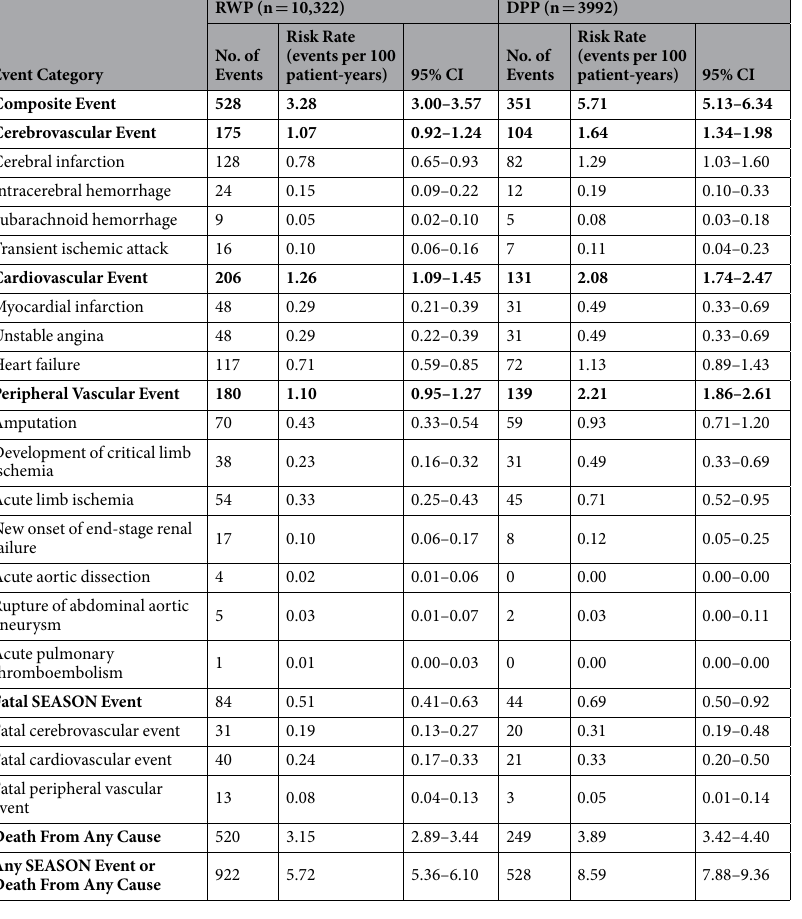
Table 2. Vascular Event and Mortality Rates Over 2 Years (RWP and DPP). Abbreviations: CI, confidence interval; DPP, definite peripheral arterial disease population; RWP, real-world